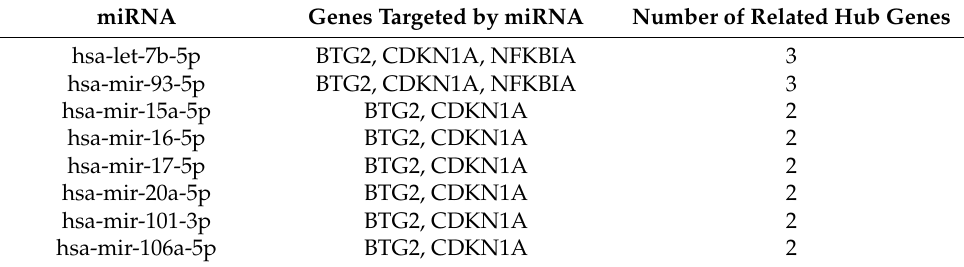
Table 3. Predicted miRNAs and genes targeted by